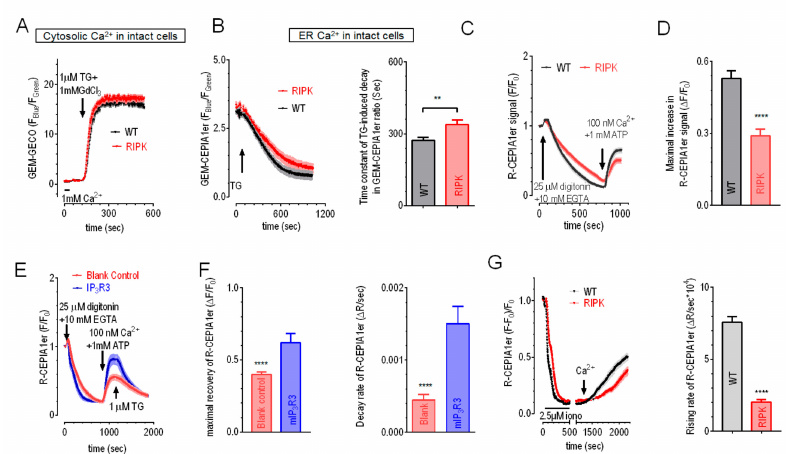
Figure 2. E ff ects of IP 3 Rs-TKO on ER Ca 2 + dynamics and corresponding changes induced by overexpression of mIP 3 R3. ( A ) Typical traces showing TG (1 µ M)-induced Ca 2 + releases in HEK WT (black trace) or RIPK (red trace) cells transiently expressing GEM-GECO. 1 mM GdCl 3 were included in external solution to block Ca 2 + movement across PM. No di ff erences in responses between WT and RIPK cells were seen (n = 2). ( B ) TG (1 µ M)-induced responses indicated with transiently